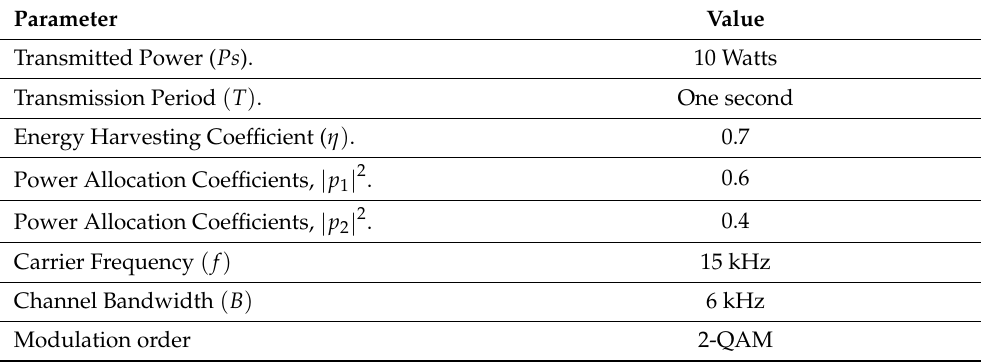
Table 1. Simulation Parameters.